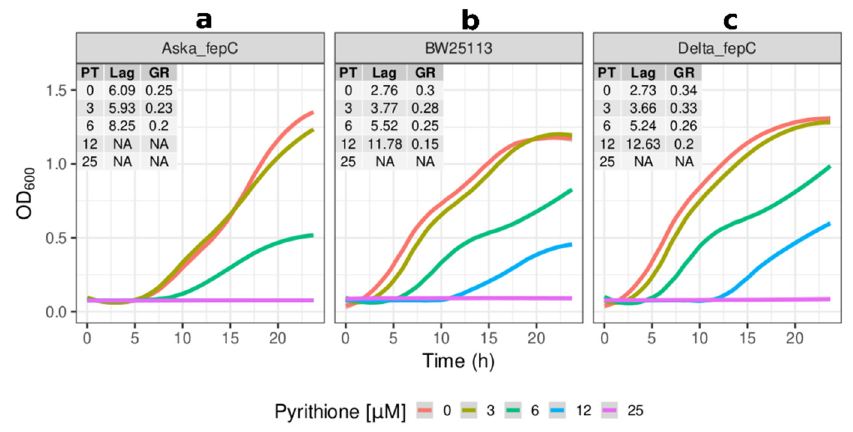
Figure 5. Effects of fepC in the sensitivity of E. coli to pyrithione. Growth (OD 600 ) at incremental concentrations of pyrithione in complex media (LB) of the ( a ) Aska clone carrying episomal copies of fepC (Aska_fepC), ( b ) the reference strain BW25113, and ( c ) the fepC knockout strain (Delta_fepC). Insets: PT: concentration of pyrithione in micromolar ( µ M), Lag: length of lag phase in hours, GR: growth rate fitted from optical densities of the cultures in exponential phases. The colour coded lines represent the fitted data with the parametric non-linear method of least squares. NA (non-applicable): data below detection limit.